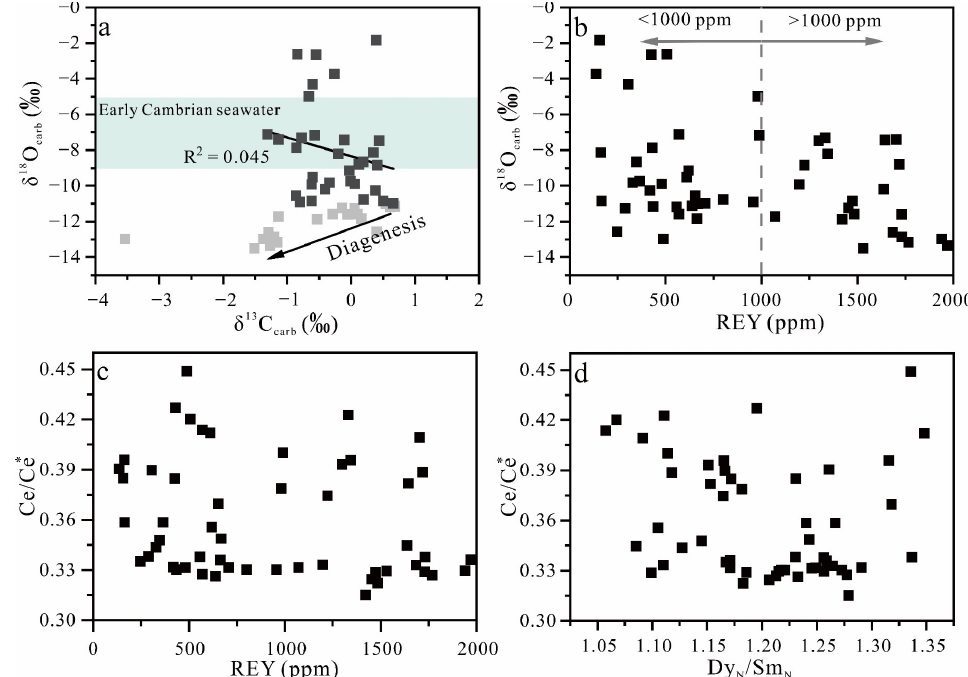
Figure 5. The discrimination of the influence of diagenesis on REY enrichment in Zhijin samples. Scatter diagram of ( a ) δ 13 C carb and δ 18 O carb , ( b ) δ 18 O carb vs. REY contents, ( c ) Ce/Ce* vs. REY contents, and ( d ) Ce/Ce* vs. Dy N /Sm N . The δ 13 C carb and δ 18 O carb ranges of early Cambrian seawater are from [3,53,54].